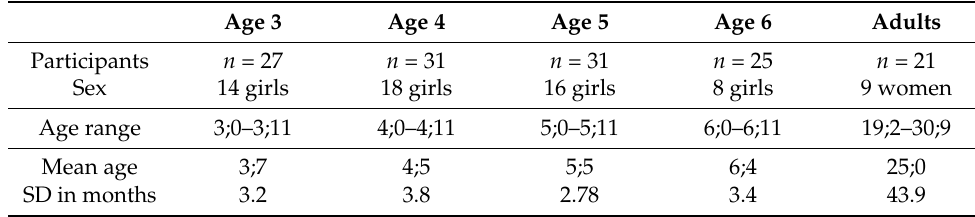
Table 1. Description of